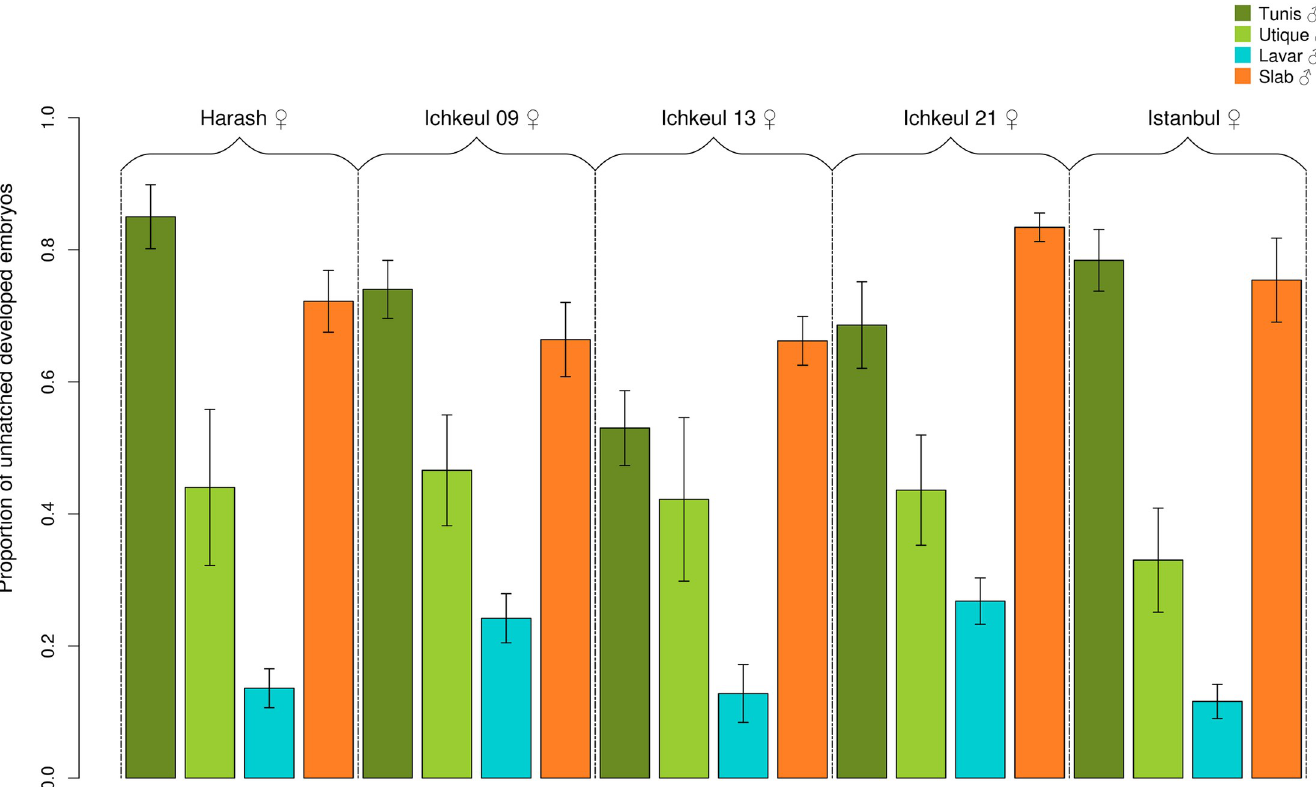
Fig 4. Variations in cellular CI intensity. Infected males from four lines exhibiting different mod profiles (M AL lines) and females from five lines with the same resc profile (F EM lines) were crossed and resulted in the 20 studied CI crosses ( i . e . > 99,9% of the embryos died before hatching). The vertical bars represent the proportion of unhatched developed embryos in each of these crosses, the four different colors represent the four different M AL lines, each group of four bars corresponding to the same F EM line. Error bars represent the standard error. The proportion of unhatched developed embryos was significantly different between crosses involving males infected with distinct w Pip responsible for different mod ; no significant effect of the F EM lines was detected.